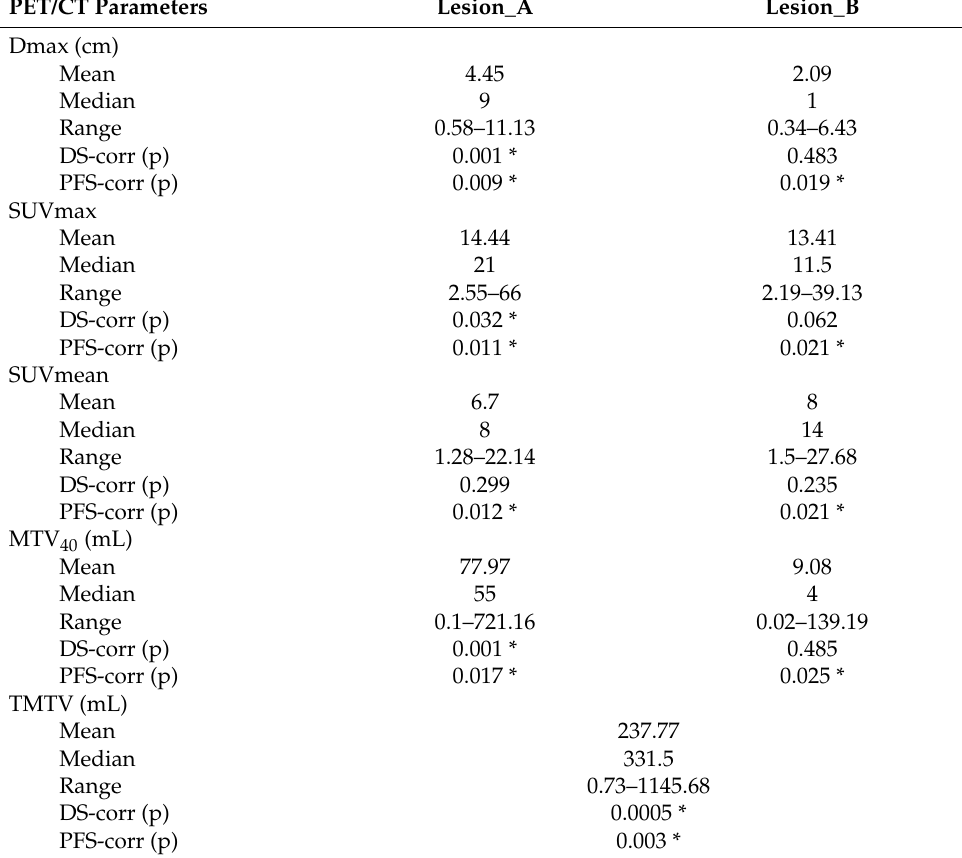
Table 3. Characteristics of bPET/CT conventional parameters and their correlation with outcomes (DS and 24-month PFS).